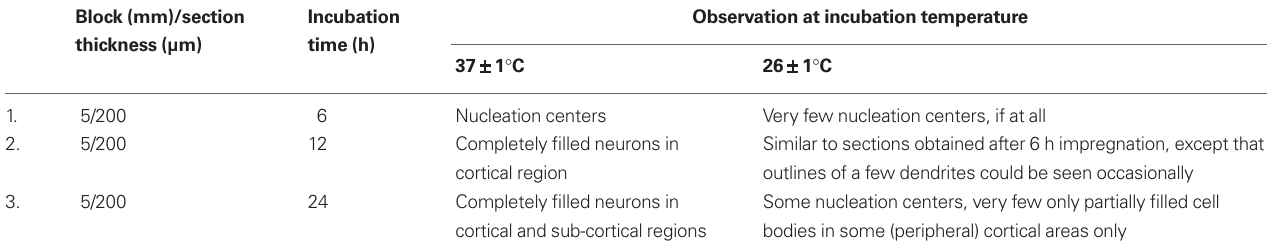
Table 2 | effects of varying duration and temperature of incubation of the brain tissues on impregnation of Golgi–Cox stain into the neurons. Block (mm)/section